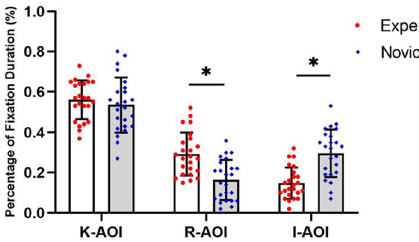
Figure 4. Comparison of the percentage of fixation duration in AOIs between groups.